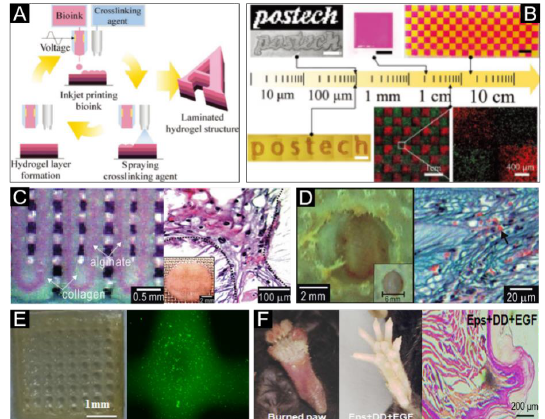
Figure 5. Ionic crosslinked bioink for skin bioprinting. ( A ) Schematic of the inkjet-spray printing process for the fabrication of laminated hydrogel structures. ( B ) Inkjet-spray-printed hydrogel structures of various scales, ranging from several hundreds of micrometers to a few tens of centimeters. The results indicated a high cell viability on the hydrogel structure. Reproduced with permission from [93]; copyright Wiley-VCH, 2018. ( C ) The optical image (Left) and optical cross-section image stained with hematoxylin and eosin (Right) of the fabricated core/shell scaffold. ( D ) The optical image (Left) and histological photomicrograph of the wound cross-section. Arrowheads indicate the generated vasculature. Reproduced with permission from [150]; copyright Royal Society of Chemistry, 2011. ( E ) Representative image (Left) of the cell-laden printed construct and fluorescence image (Right) of cells embedded in the printed construct. ( F ) Sweat gland regeneration (Middle) and histology of wound healing (Right) in mouse paw after 3D-ECM mimics implantation; the burned mouse paw is shown on the left. Reproduced with permission from [82]; copyright Elsevier,